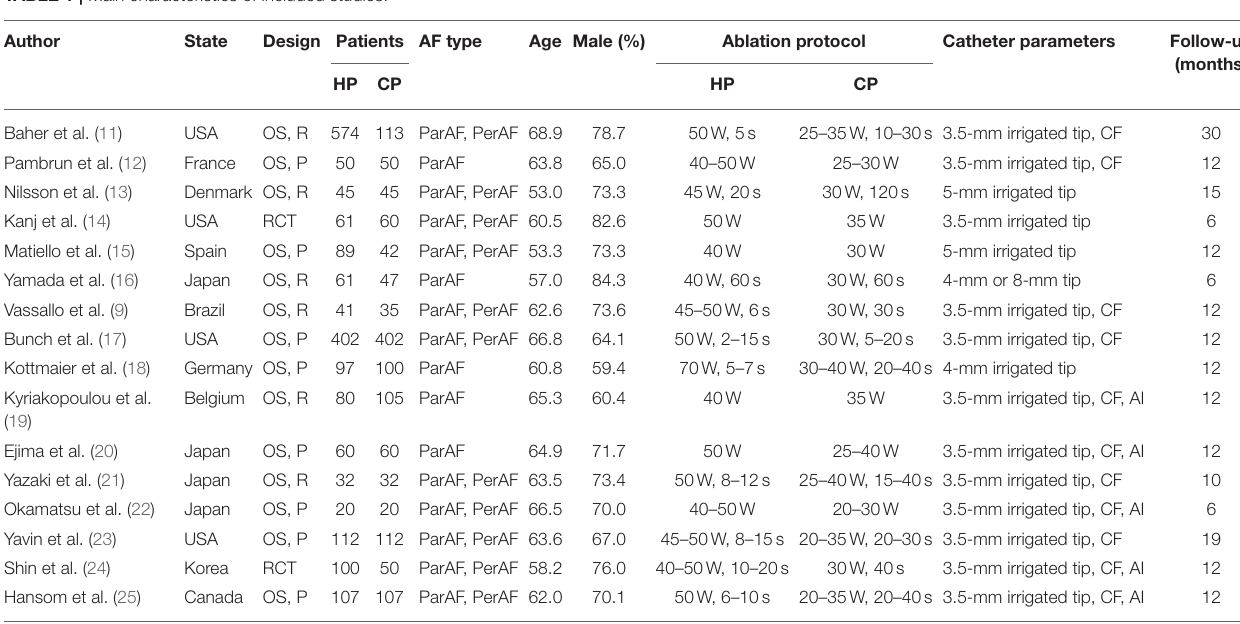
TABLE 1 | Main characteristics of included